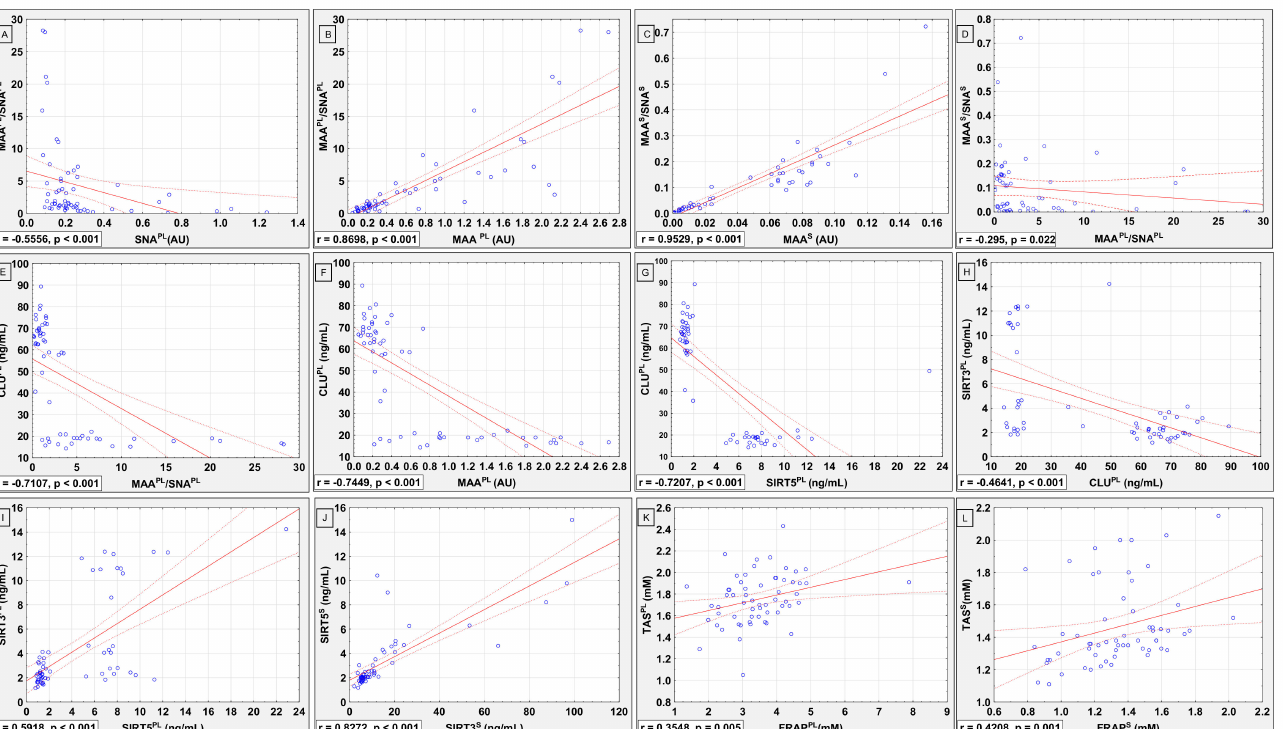
Figure 1. The correlations between selected parameters in seminal plasma ( A , B , E – I , K ) and blood serum ( C , J , L ) and comparison of MAA/SNA sialylation ratio between both biological fluids ( D ). MAA PL /SNA PL -seminal plasma sialylation ratio; SNA PL -relative reactivity of seminal plasma CLU glycans with Sambucus nigra agglutinin; MAA PL -relative reactivity of seminal plasma CLU glycans with Maackia amurensis agglutinin; MAA S /SNA S -serum sialylation ratio; MAA S -relative reactivity of serum CLU glycans with Maackia amurensis agglutinin; CLU PL -seminal plasma CLU concentra- tion; SIRT5 PL -seminal plasma SIRT5 concentration; SIRT3 PL -seminal plasma SIRT3 concentration; SIRT5 S -serum SIRT5 concentration; SIRT3 S -serum SIRT3 concentration; TAS PL -seminal plasma total antioxidant status; FRAP PL -seminal plasma ferric reducing antioxidant power; TAS S -serum total antioxidant status; FRAP S -serum ferric reducing antioxidant power. The red dashed line points 95% of confidence interval. A two-tailed p value of less than 0.05 was considered